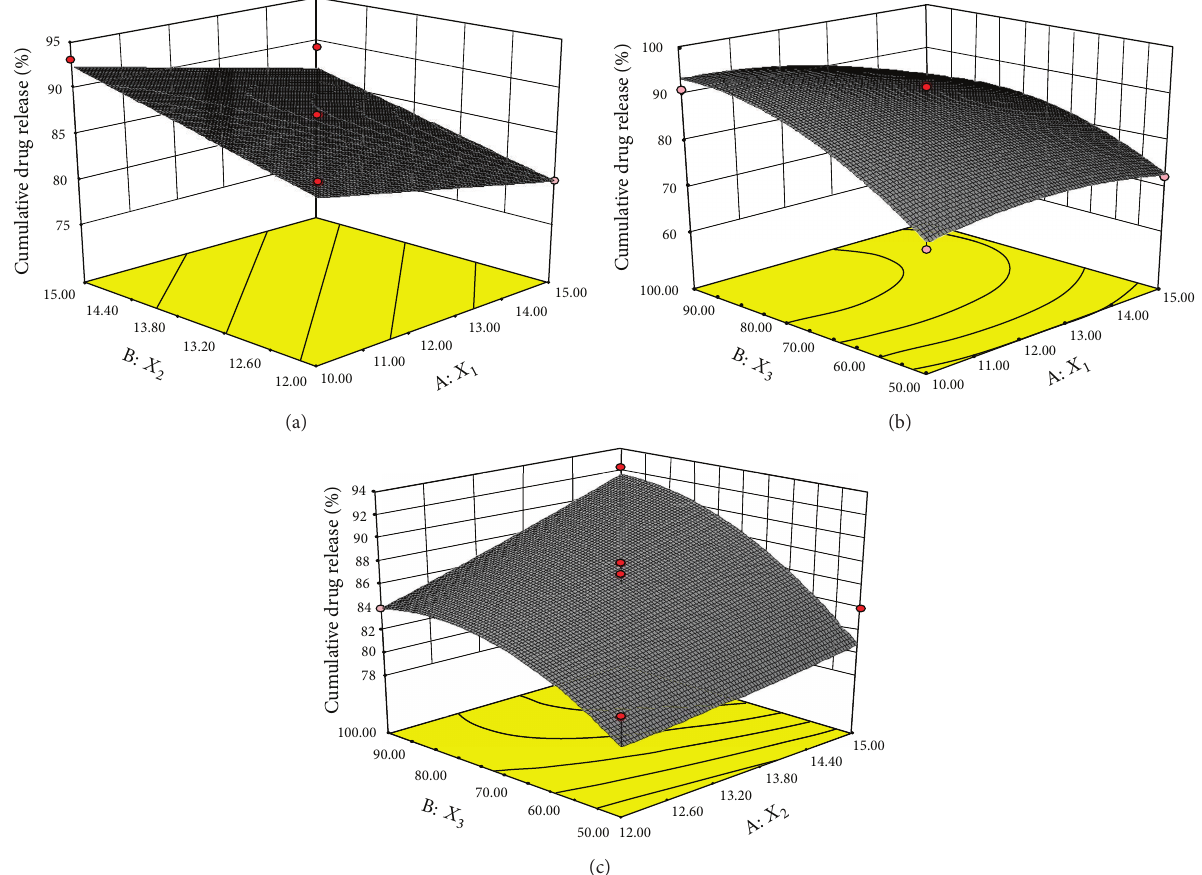
Figure 3: 3D-response surface plots for percentage of cumulative drug release as functions of two